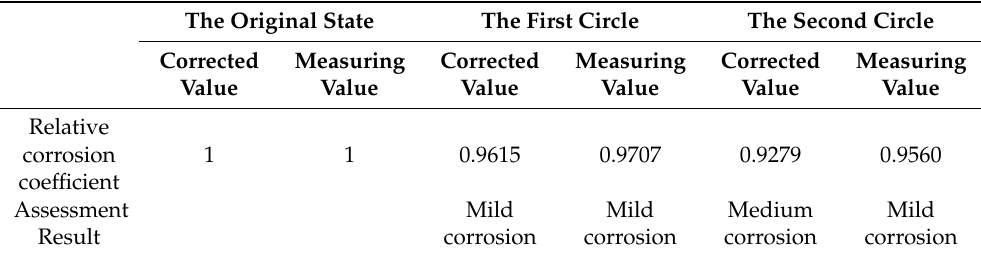
Table 9. The relative corrosion coefficient of the sulfate attack of the specimen.